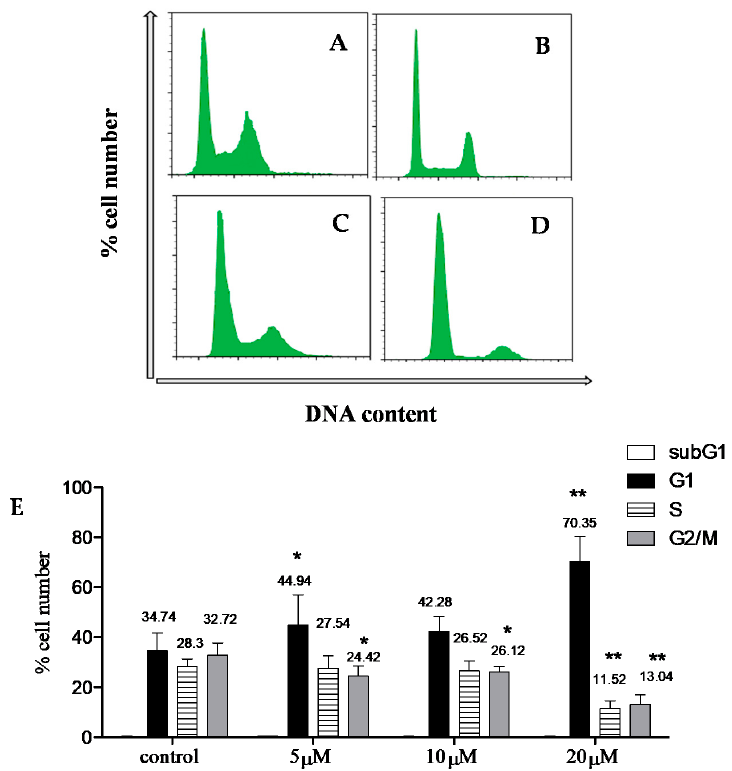
Figure 3. Graphs showing effect of compound 1 (24 h; ( A ): 0, ( B ): 5 µM, ( C ): 10 µM, and ( D ): 20 µM) in MCF 7 cell cycle distribution. ( E ): Data shown are mean % ± SD (n = 2). Experiment was repeated 3 × ( n = 3). Statistical differences compared to untreated control cells were assessed by one-way ANOVA with the Tukey’s post-hoc multiple comparison test. p < 0.1 (*) and p < 0.01 (**) were taken as